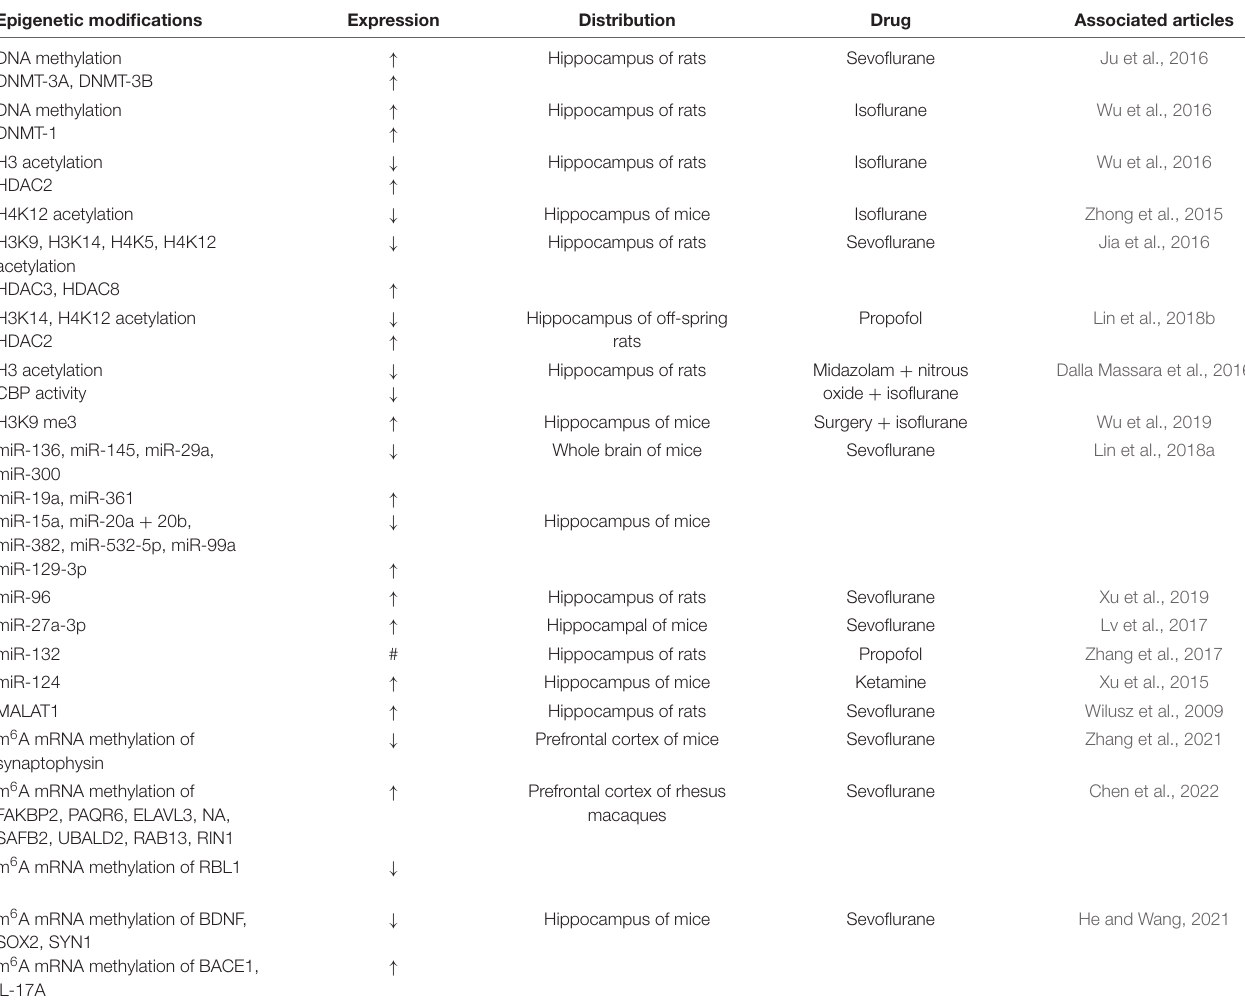
TABLE 1 | Neonatal GA exposure-induced epigenetic